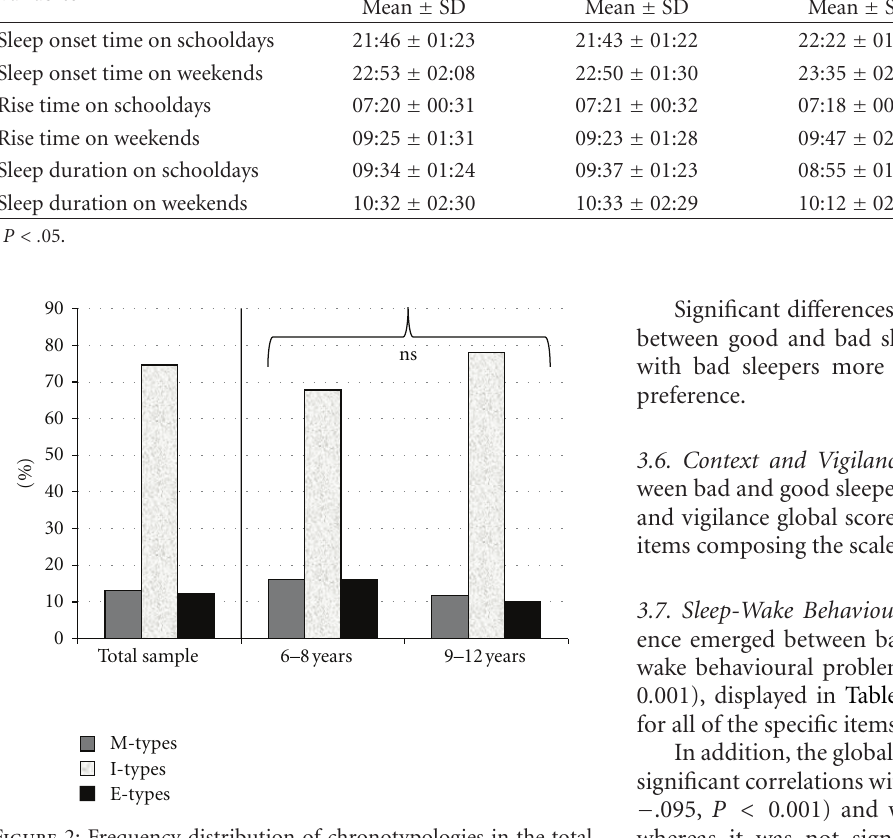
Figure 2: Frequency distribution of chronotypologies in the total sample and in two age groups (6–8 and 9–12